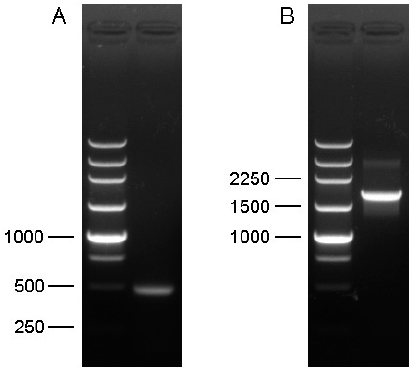
Figure 1. Elelctrophoretic analysis of ( A ) partial fragment and ( B ) end-to-end RT-PCR for full-length transcript of Cs-Phm.